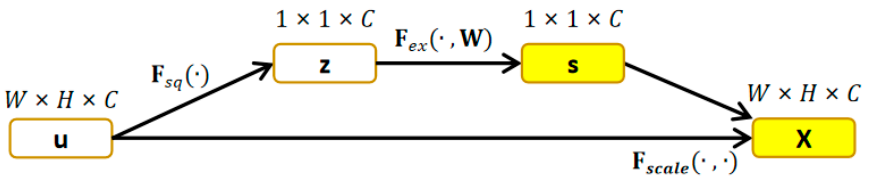
Figure 2. The structure of